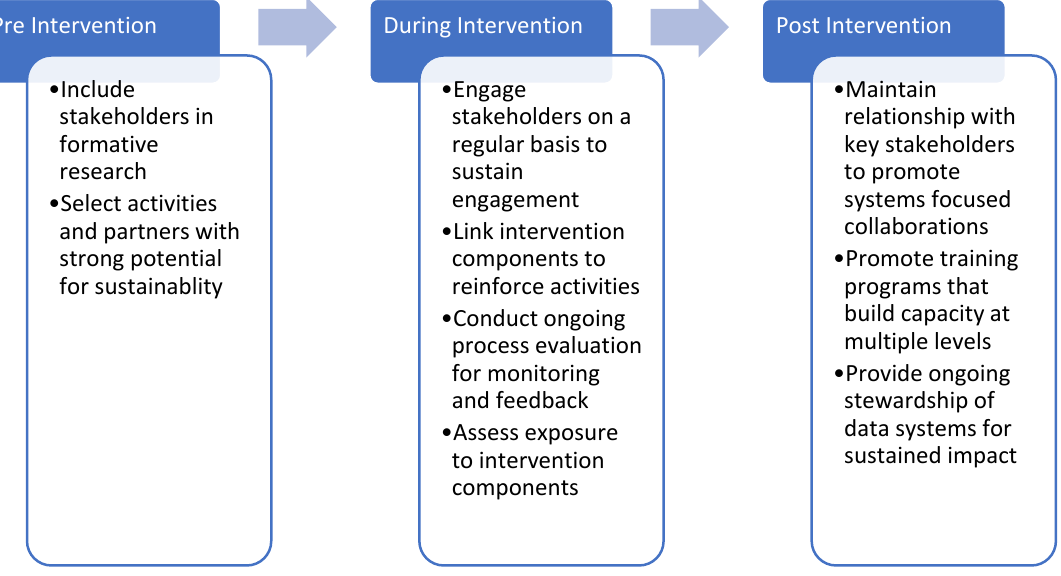
Figure 1. Summary of lessons learned by three multi-level multi-component (MLMC) community-based childhood obesity prevention studies.